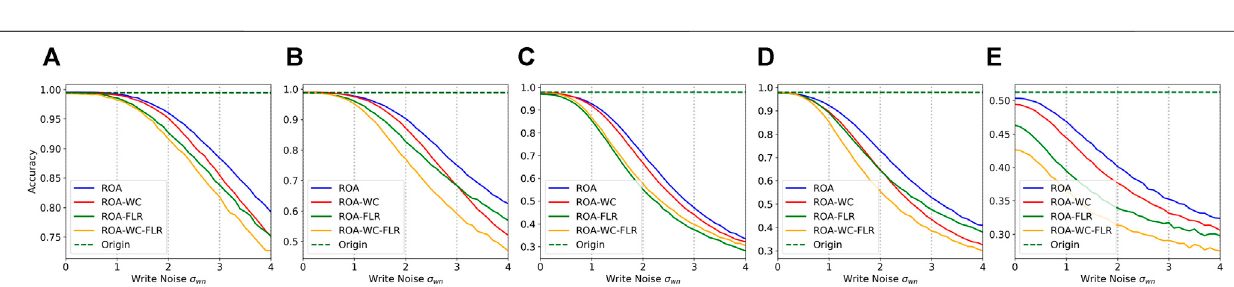
FIGURE 4 | Comparison of the accuracy of 5-step update of fl ine and ROA in different write noise. (A) 5way-1shot on Omniglot. (B) 10way-1shot on Omniglot. (C) 20way-1shot on Omniglot. (D) 5way-1shot on MiniImageNet.